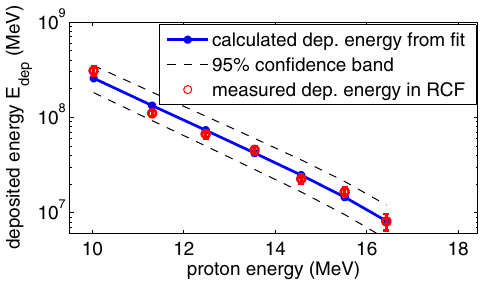
FIG. 7. Measured deposited energy (red circles) in RCFs when focusing 10 MeV protons at 2.12 m and corresponding expo- nential fit (blue line).